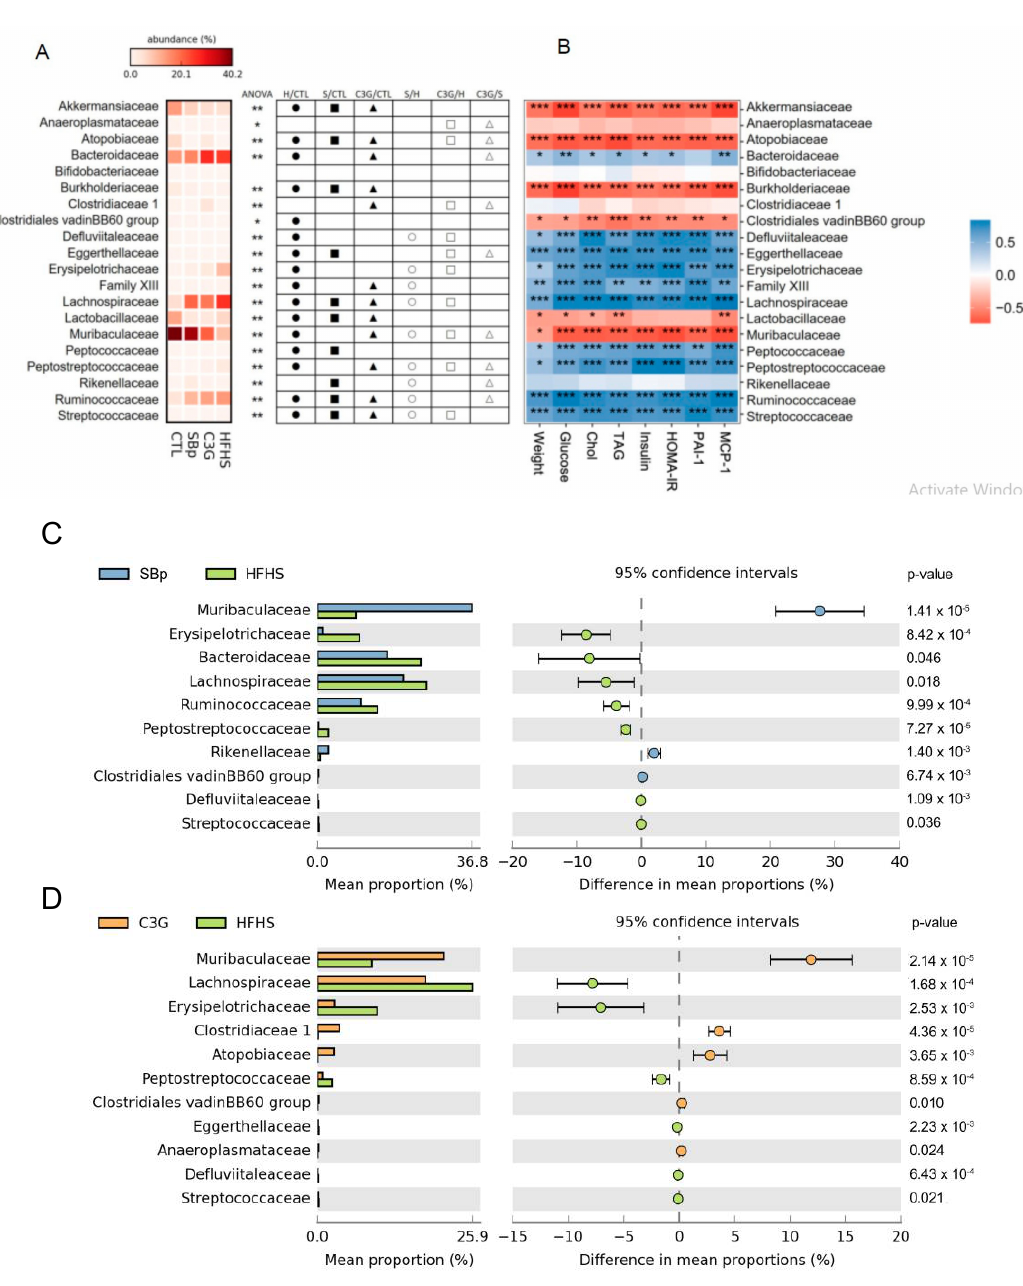
Figure 7. E ff ect of four HFHS (H) diets supplemented with C3G on the relative abundance of gut family bacteria. The experimental regimen was described in the legend of Figure 1. ( A ) Statistical di ff erences among mice with di ff erent diets (analysis of variance (ANOVA) and post-hoc Tukey test), ( B ) correlation heatmap of relative abundance of gut microbiota on family level with physiological and biochemical parameters, ( C ) extended error bar plot (STAMP tool) showing di ff erence in mean relative abundance between the SBp (S) group and HFHS group, ( D ) mean proportion and di ff erence in mean proportion of family bacteria (STAMP tool) between the C3G group and the HFHS group (mean ± SD). ∗ : p < 0.05 in overall ANOVA result, • : p < 0.05 in the HFHS (H) group versus the control (CTL) group (H / CTL), (cid:4) : p < 0.05 in the SBp (S) group versus the CTL group (S / CTL), (cid:78) : p < 0.05 in the C3G group versus the CTL group (C3G / CTL), : p < 0.05 in the S group versus the H group (S / H), (cid:3) : p < 0.05 in (cid:35) the C3G group versus the H group (C3G / H), (cid:52) : p < 0.05 in the C3G group versus the S group (C3G / S). *, **, ***: p < 0.05 or 0.01 or 0.001 in positive (blue) or negative (red) correlations between the abundance of each gut family bacteria and physiological or biochemical